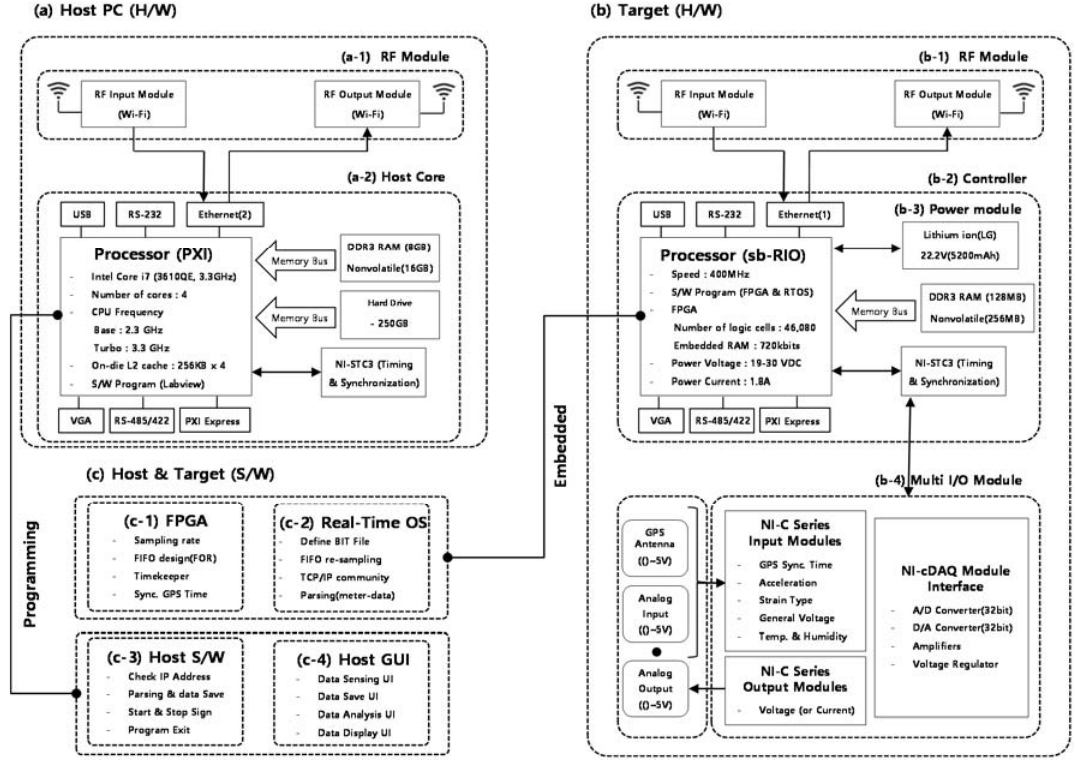
Figure 1. Wireless unified ‐ maintenance system (WUMS): ( a ) Host PC; ( b ) target; ( c ) host and target S/W.